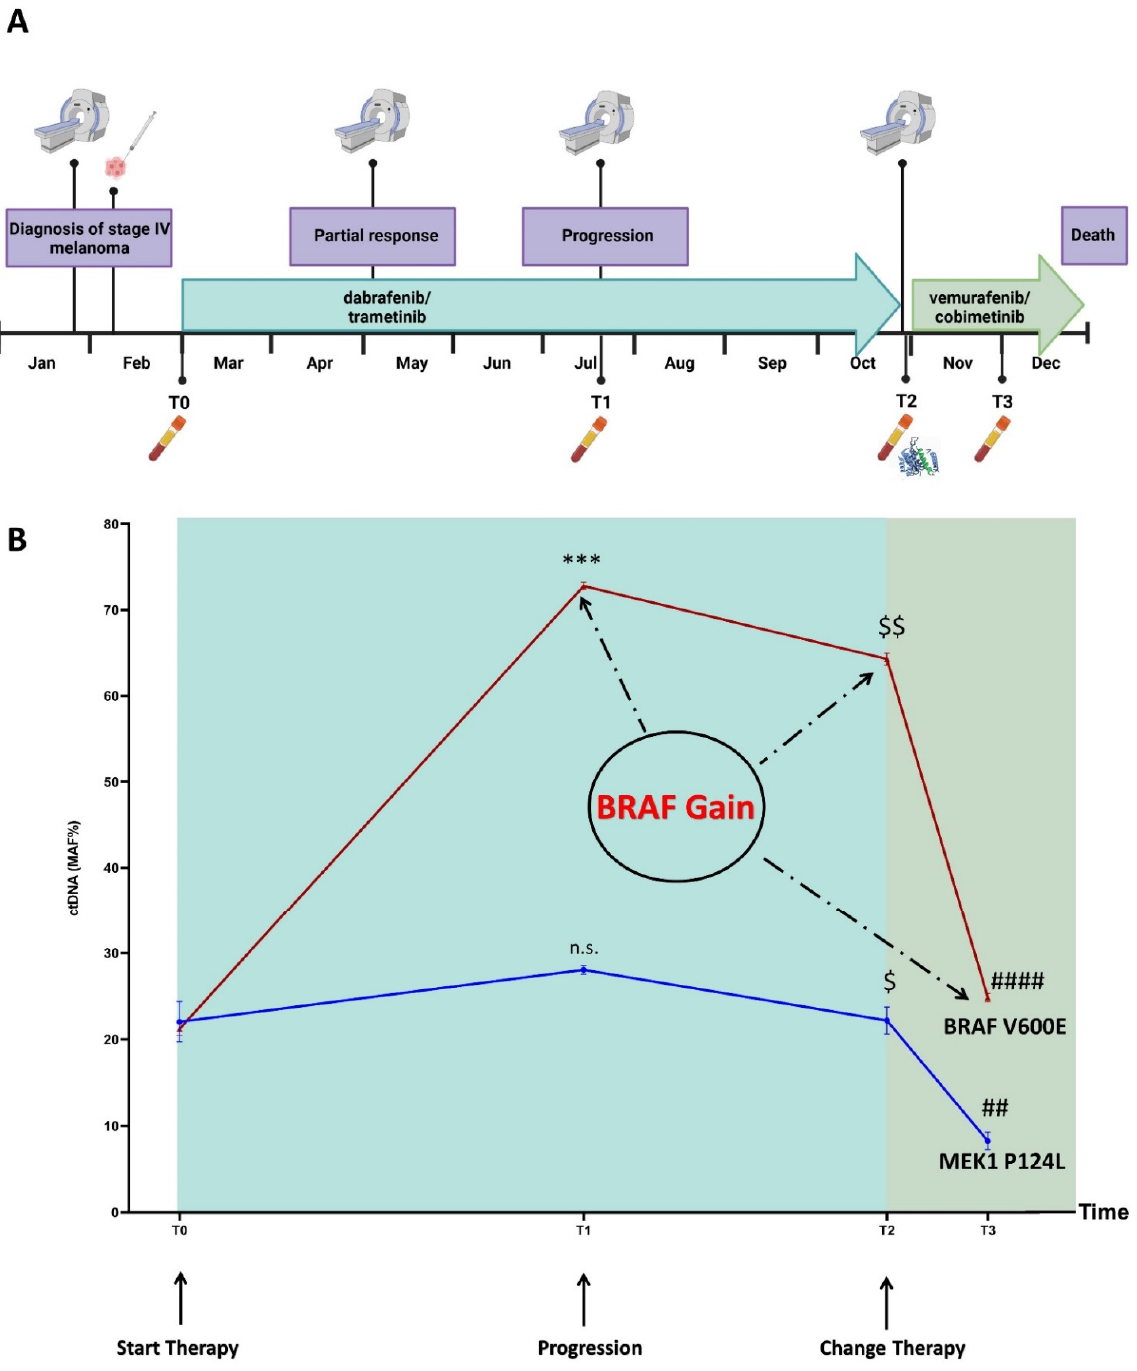
Figure 2. Timeline ( A ) and longitudinal plot ( B ) of BRAF p.V600E and MEK1 p.P124L MAFs (%) detected in ctDNA by NGS and ddPCR (average from values obtained by two or three independent settings). BRAF p.V600E MAFs: 21.01% (T0); 72.75% (T1); 64.30% (T2); 24.86% (T3). MEK1 p.P124L MAFs: 22.05% (T0); 28.05% (T1); 22.20% (T2); 8.26% (T3). $ p ≤ 0.05 T2 versus T1; $$ p ≤ 0.001 T2 versus T1; ## p ≤ 0.001 T3 versus T2; *** p ≤ 0.0001 T1 versus T0; #### p ≤ 0.000001 T3 versus T2; n.s. = not significant. The timeline was created with BioRender (https://biorender.com/, accessed on 24 June 2022); the plot was performed using GraphPad version 8.0 for Windows (GraphPad Software Inc., San Diego, CA,